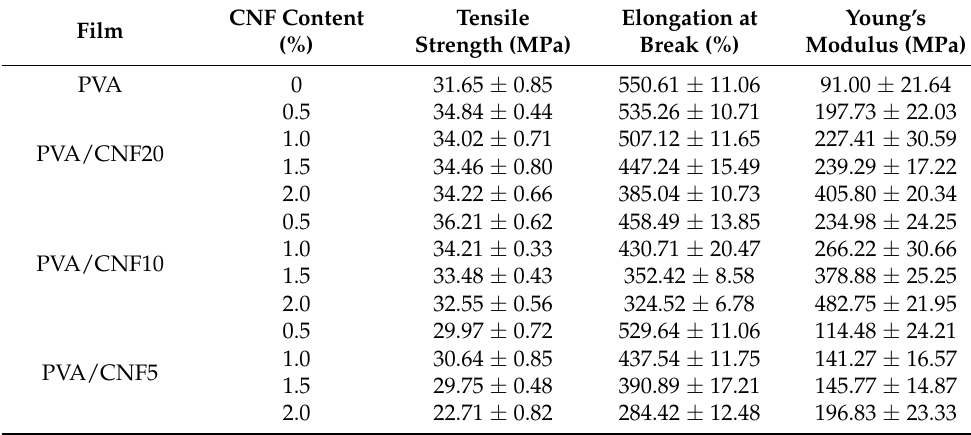
Table 2. The tensile properties of pure PVA and PVA/CNF